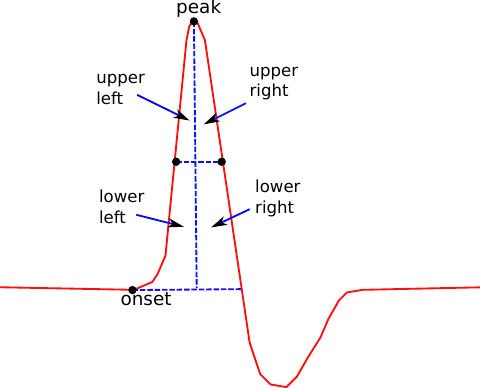
Figure 7. Several features related to definitions about